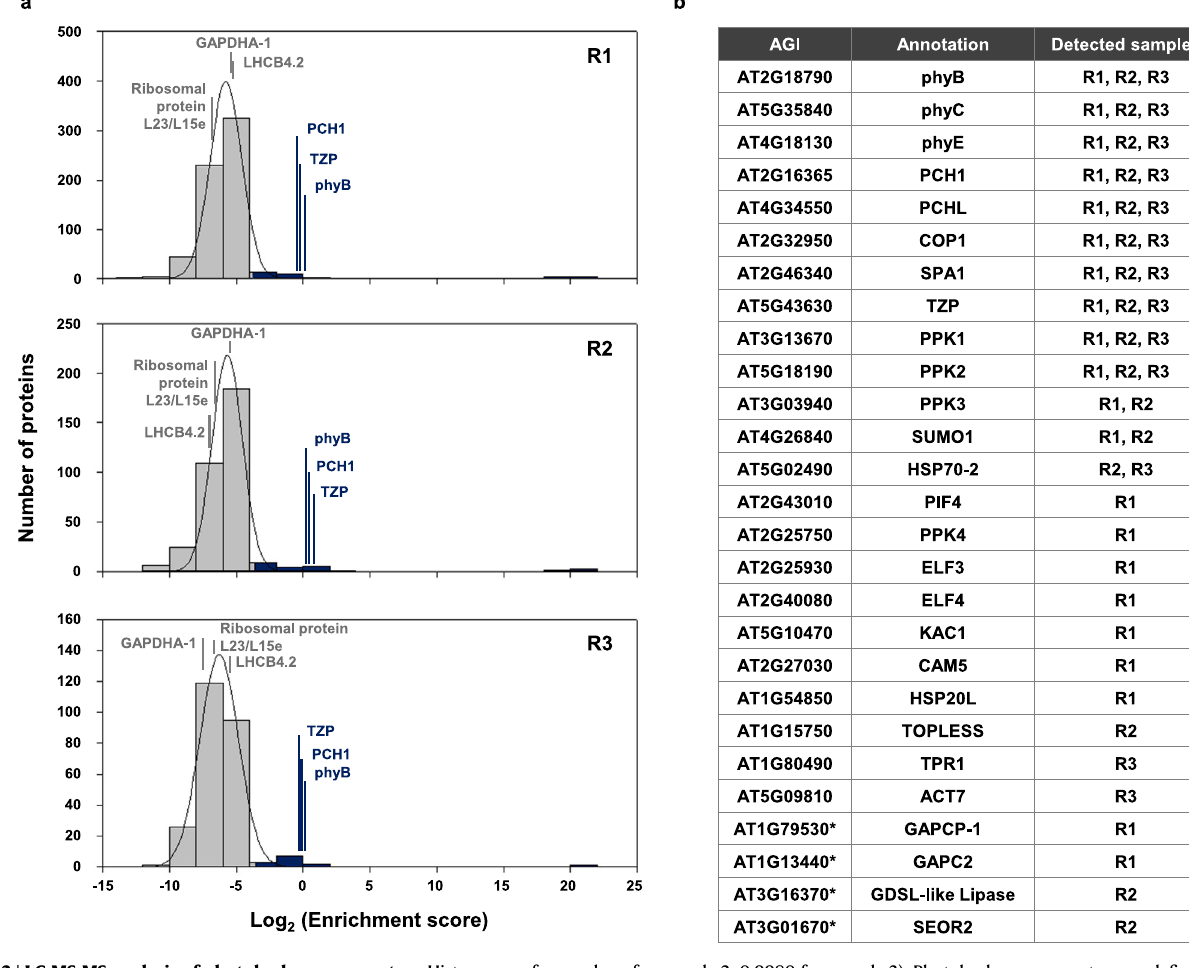
for sample 2, 0.9980 for sample 3). Photobody components were de fi ned as pro- teins whose Log 2 (Enrichment score) was higherthan μ +2 σ value (darkblue bars) where μ is the average and σ is the standard deviation of the fi tted normal dis- tribution curve. The positions of phyB, PCH1, and TZP are indicated. b The candi- datelistofphotobodycomponents.Proteinsthatmeetthecriteriadescribedin( a ) were selected as the candidates for the phyB photobody components. Four pro- teins excluded from the candidates are indicated by asterisk (*). Source data are provided as a Source Data fi